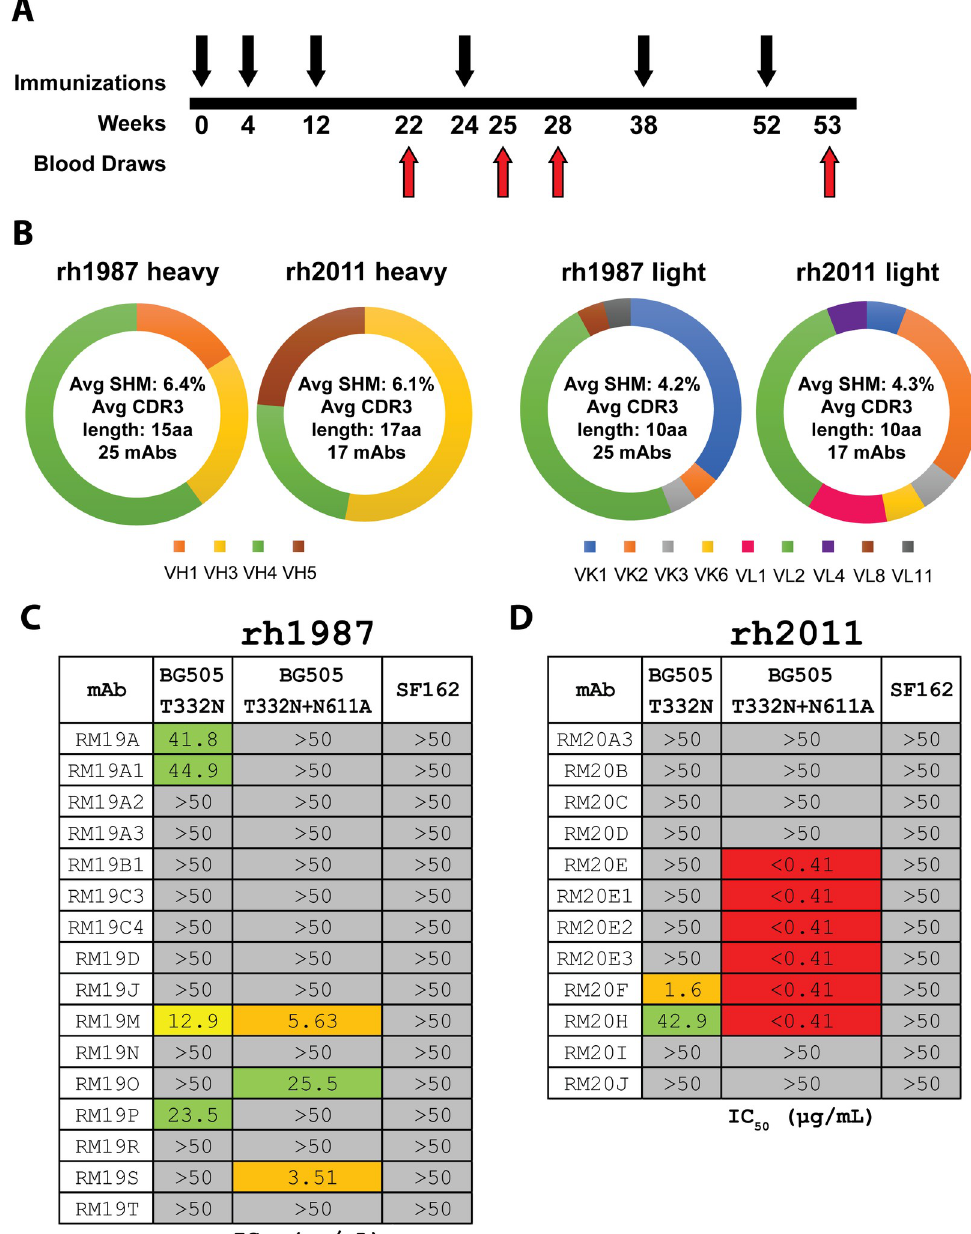
Fig 1. MAb isolation and characterization from BG505 SOSIP.664 trimer-immunized RMs. (A) Simplified immunization scheme as described in Sanders et al. 2015 [24]. Black arrows indicate i.m. immunizations with 100 μ g of BG505 SOSIP.664 with 75 units of ISCOMATRIX adjuvant. Red arrows indicate blood draws. (B) Heavy and light chain genetic characteristics for mAbs isolated from rh1987 and rh2011. (C) TZM-bl neutralization of BG505.T332N, BG505. T332N.N611A, and SF162 pseudoviruses for mAbs isolated from RM rh1987. (D) TZM-bl neutralization of BG505. T332N, BG505.T332N.N611A, and SF162 pseudoviruses for mAbs isolated from RM rh2011. Assay limit of detection was at an IC 50 of 50 μ